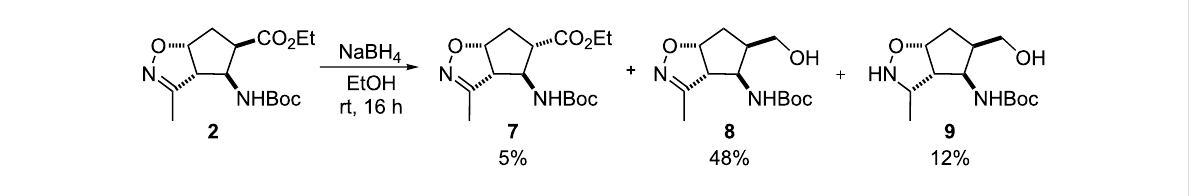
Scheme 2: Treatment of isoxazoline-fused amino ester 2 with NaBH 4 .